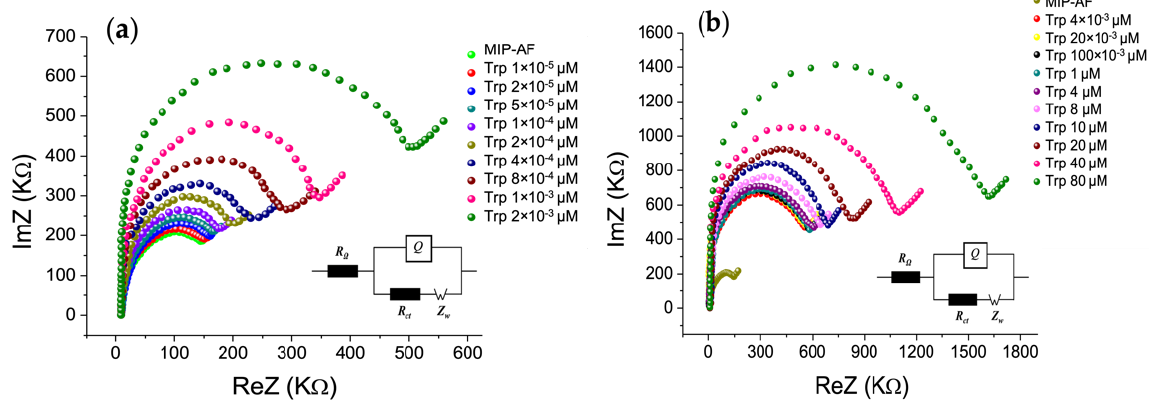
Figure 3. EIS Nyquist plot for characterizing MIP-AF development and its application for determining Trp in PBS; ( a ) EIS Nyquist plot for characterizing the impedance spectra of Trp analyte at lower concentrations (1 × 10 − 5 –2 × 10 − 3 µ M); ( b ) impedance spectra of further higher concentration (4 × 10 − 3 –80 µ M) of Trp. The inset shows Randle equivalent circuit, where R Ω is the solution resistance, R ct is the charge transfer resistance, Q is the constant phase element, and Z w is Warburg’s impedance.